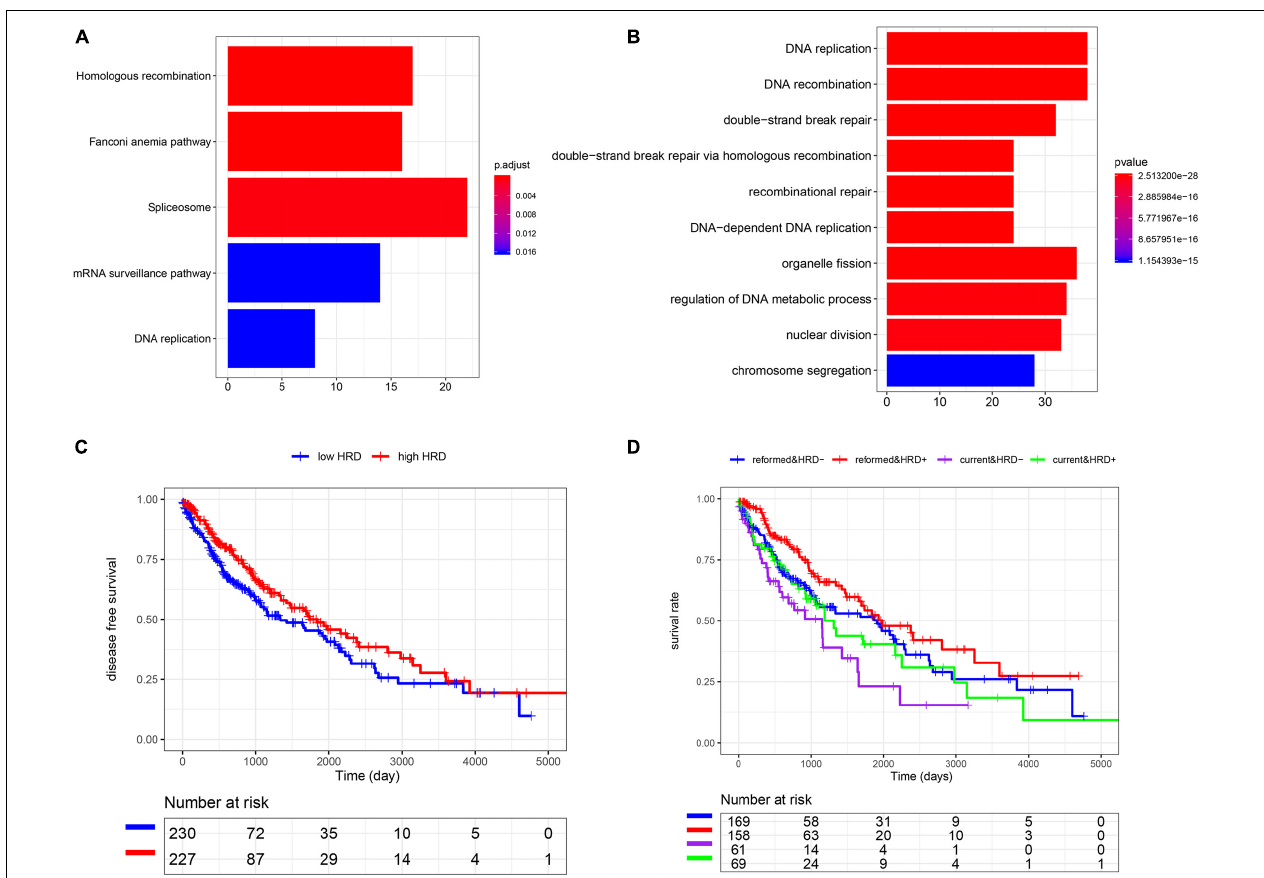
FIGURE 3 | The association among smoking cessation, HRD, and prognosis in LUSC. (A) The KEGG analysis. (B) The GO analysis. (C) K-M analysis of high and low HRD scores. (D) The effect of cross-talk between the smoking status and homologous recombination on the prognosis.